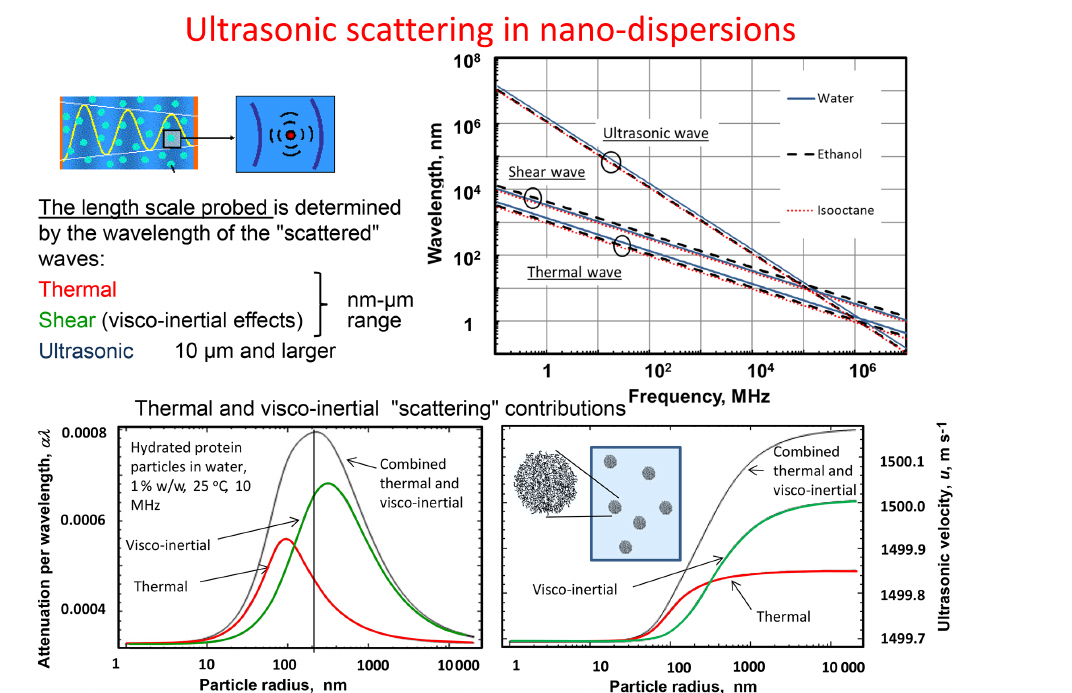
Figure 2. Ultrasonic scattering effects in nano-dispersions. Dependence of ultrasonic attenuation per wavelength, αλ , and ultrasonic velocity, in suspensions of hydrated protein particles (at constant concentration) on their radius in water at 25 ◦ C at 10MHz frequency calculated with HR-US particle size module (Sonas technologies Ltd. Dublin); the physical properties of the protein particles and of water were provided with the software. The hydration level of protein (water-to-protein ratio) is 0.35w / w. The concentration of protein particles in the suspension is 0.0135w / w, which corresponds to the concentration of protein, 0.01w / w. For simplicity the intrinsic attenuation in protein particles was